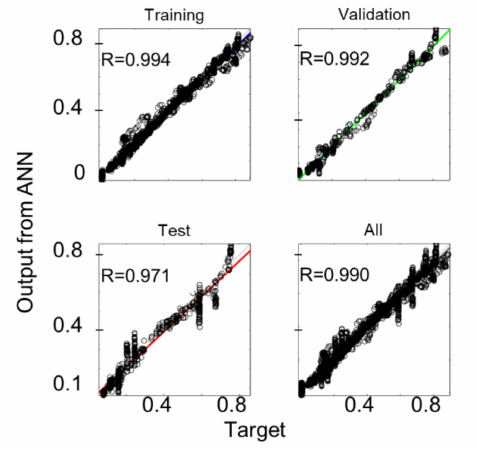
Figure 6. Results of the ANN training for ROI A. Here, R is the angular coefficient of the linear regression: the closer R is to 1, the more accurate the ANN is in approximating the numerical simulation FOD